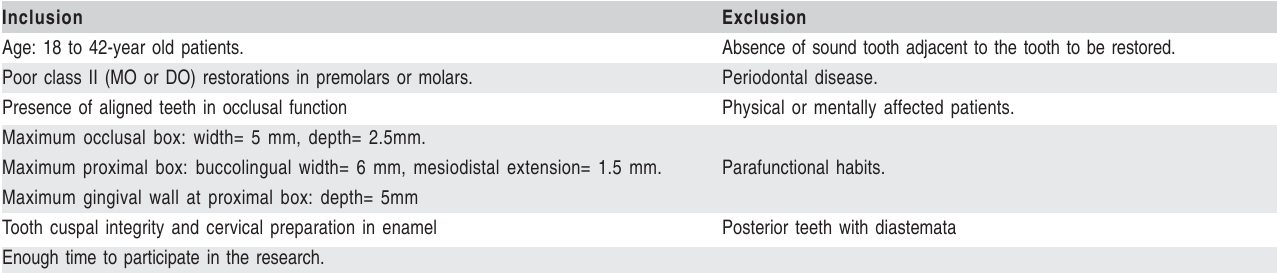
Table 1: Inclusion and exclusion criteria .